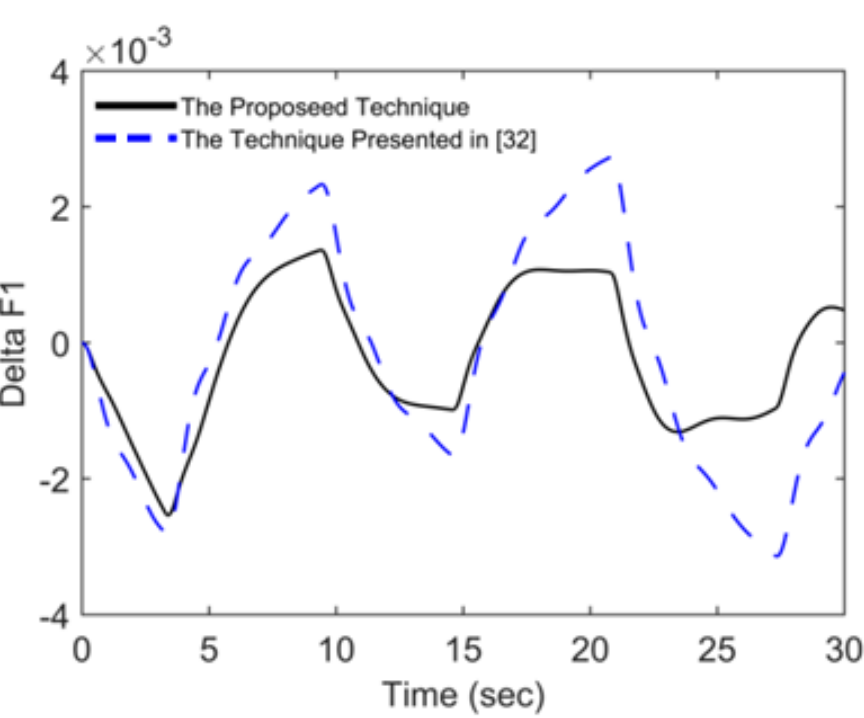
Figure 10. Frequency deviation (p.u.) in area 1 under the variation in WECS as a disturbance.